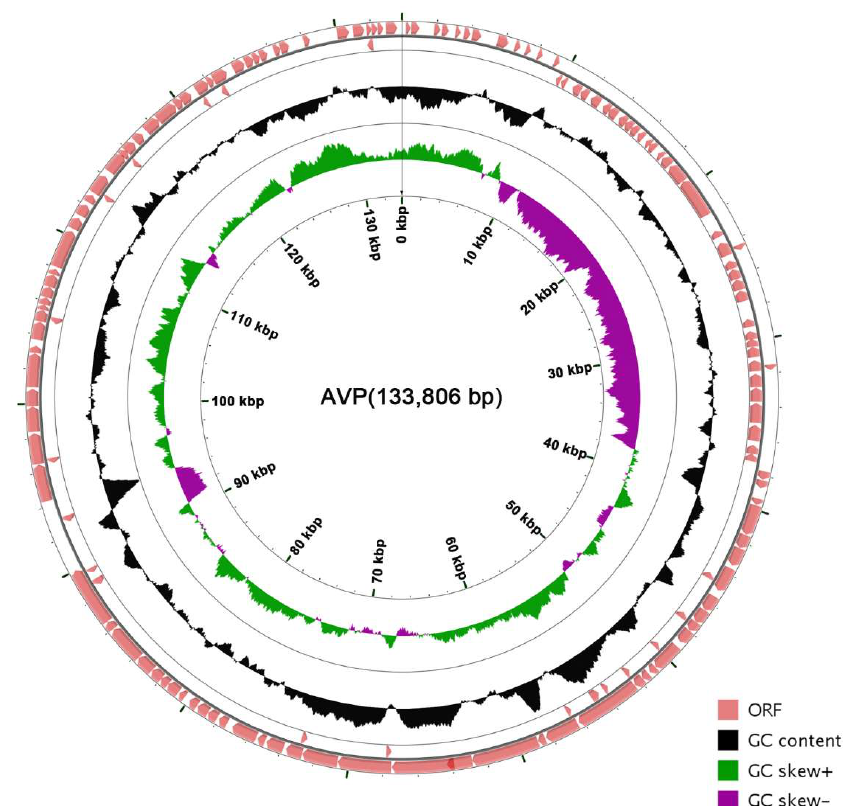
Figure 2. One-step growth curve for vB_AviM_AVP (AVP) in Aerococcus viridans AV-X1. Shown are samples treated with ( ▲ ) and without (●) chloroform at different time points. The values indicate means and standard deviations (SD) ( n = 3).